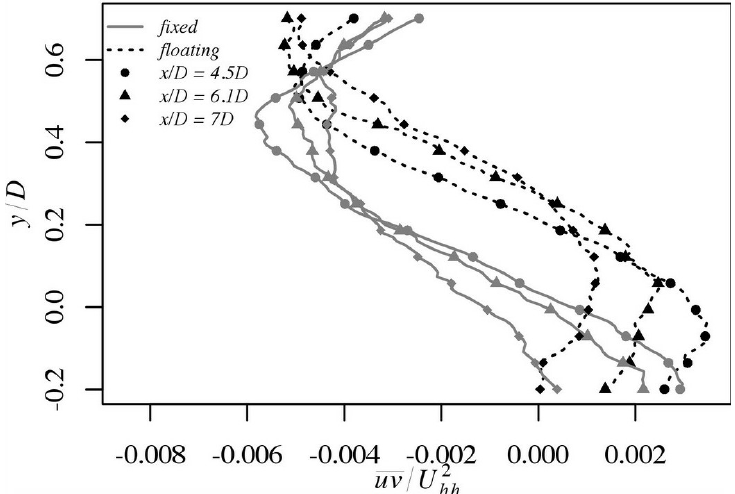
Figure 15. Far wake profiles of uv / U 2 distances 4.5 D , 6.1 D and 7 D